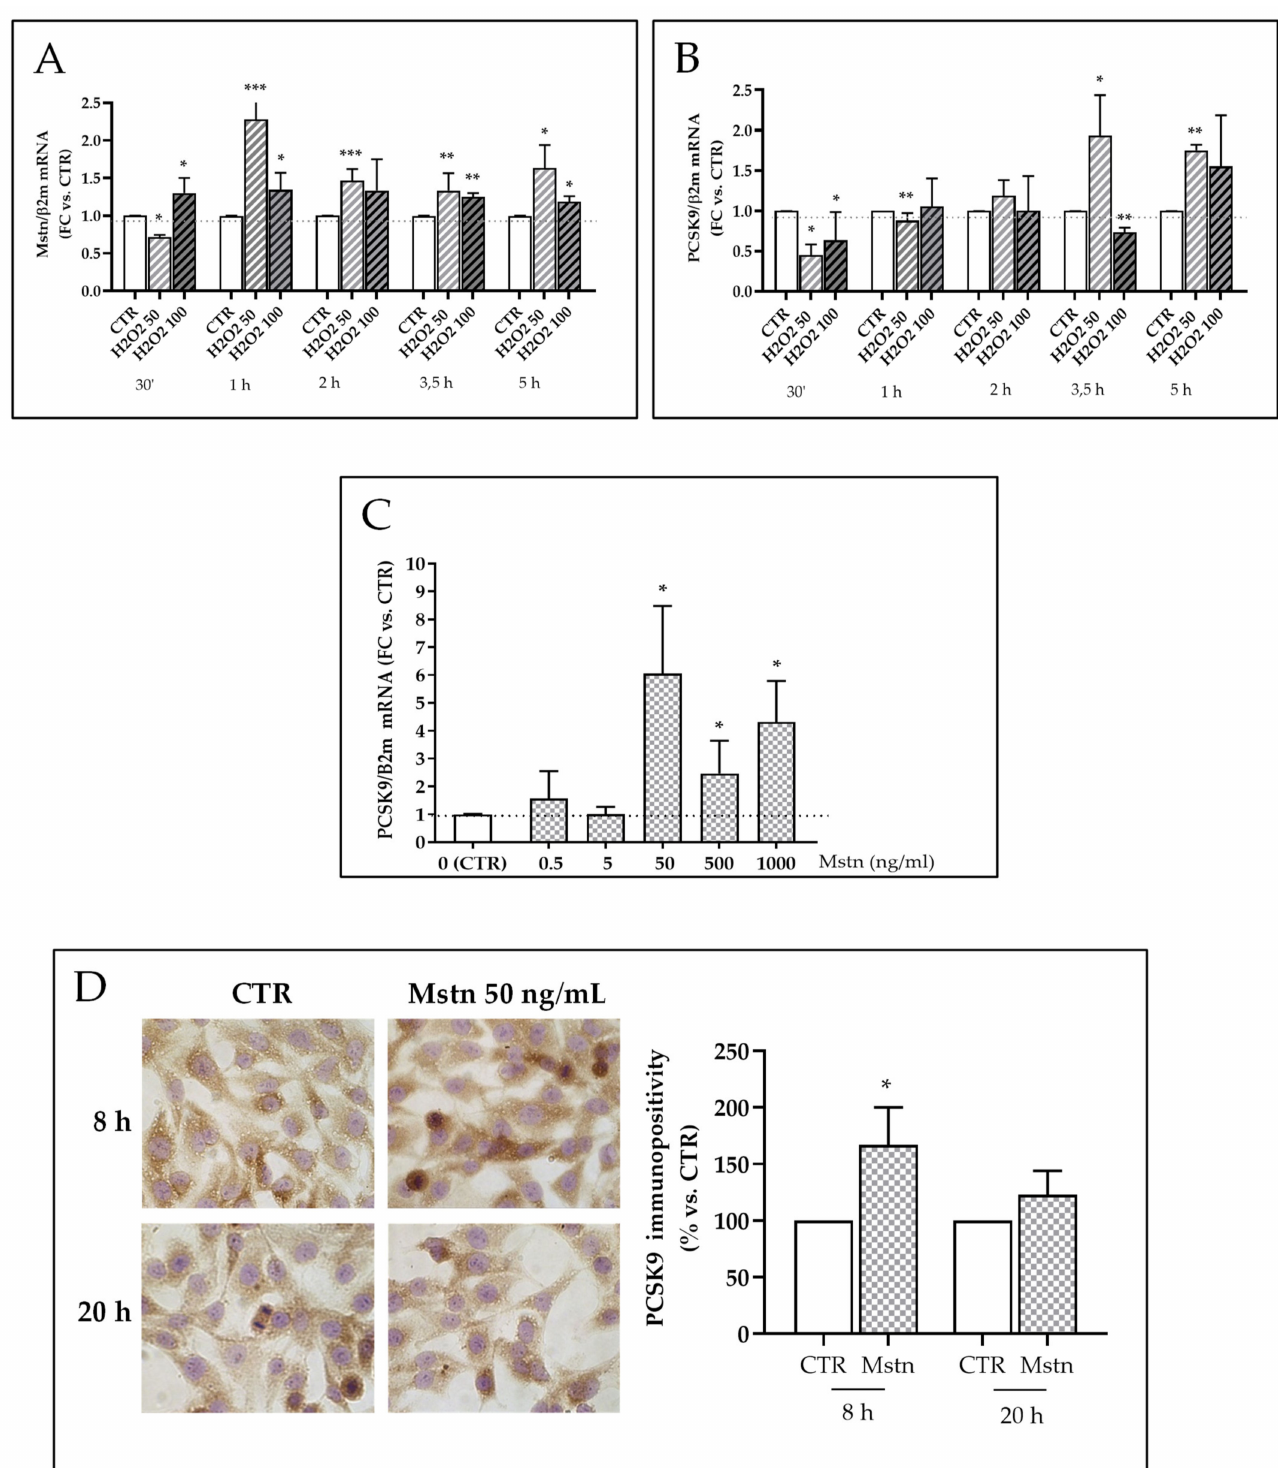
Figure 7. Mstn and PCSK9 in HK-2 tubular renal cells. ( A ) Mstn and ( B ) PCSK9 mRNA levels upon H 2 O 2 treatment; * p < 0.05, ** p < 0.01, *** p < 0.001. ( C ) PCSK9 mRNA levels after a 5 h treatment with Mstn (0,5, 5, 50, 500, 1000 ng/mL). The results were obtained by quantitative real-time PCR, normalized expressing the number of transcript copies as a ratio to β 2-microglobulin ( β 2-m) and indicated as fold changes (FC) in comparison to untreated control cells; * p < 0.05. ( D ) PCSK9 immunocytochemistry using DAB as chromogen, representative images (left side); immunostaining quantification, indicated as % of immunopositivity in respect to control cells (right side). Data are obtained from 3 independent experiments and the signal measured in 50 cells/samples at least; * p <